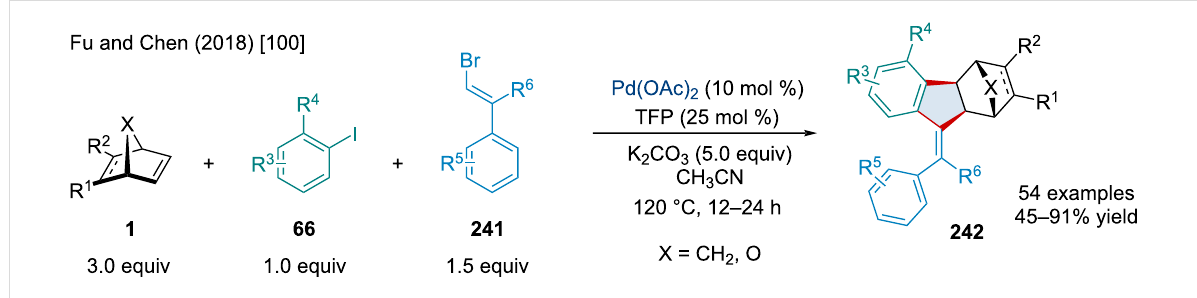
Scheme 46: Pd-catalyzed, three-component annulation of aryl iodides 66 , alkenyl bromides 241 , and bicyclic alkenes 1 .